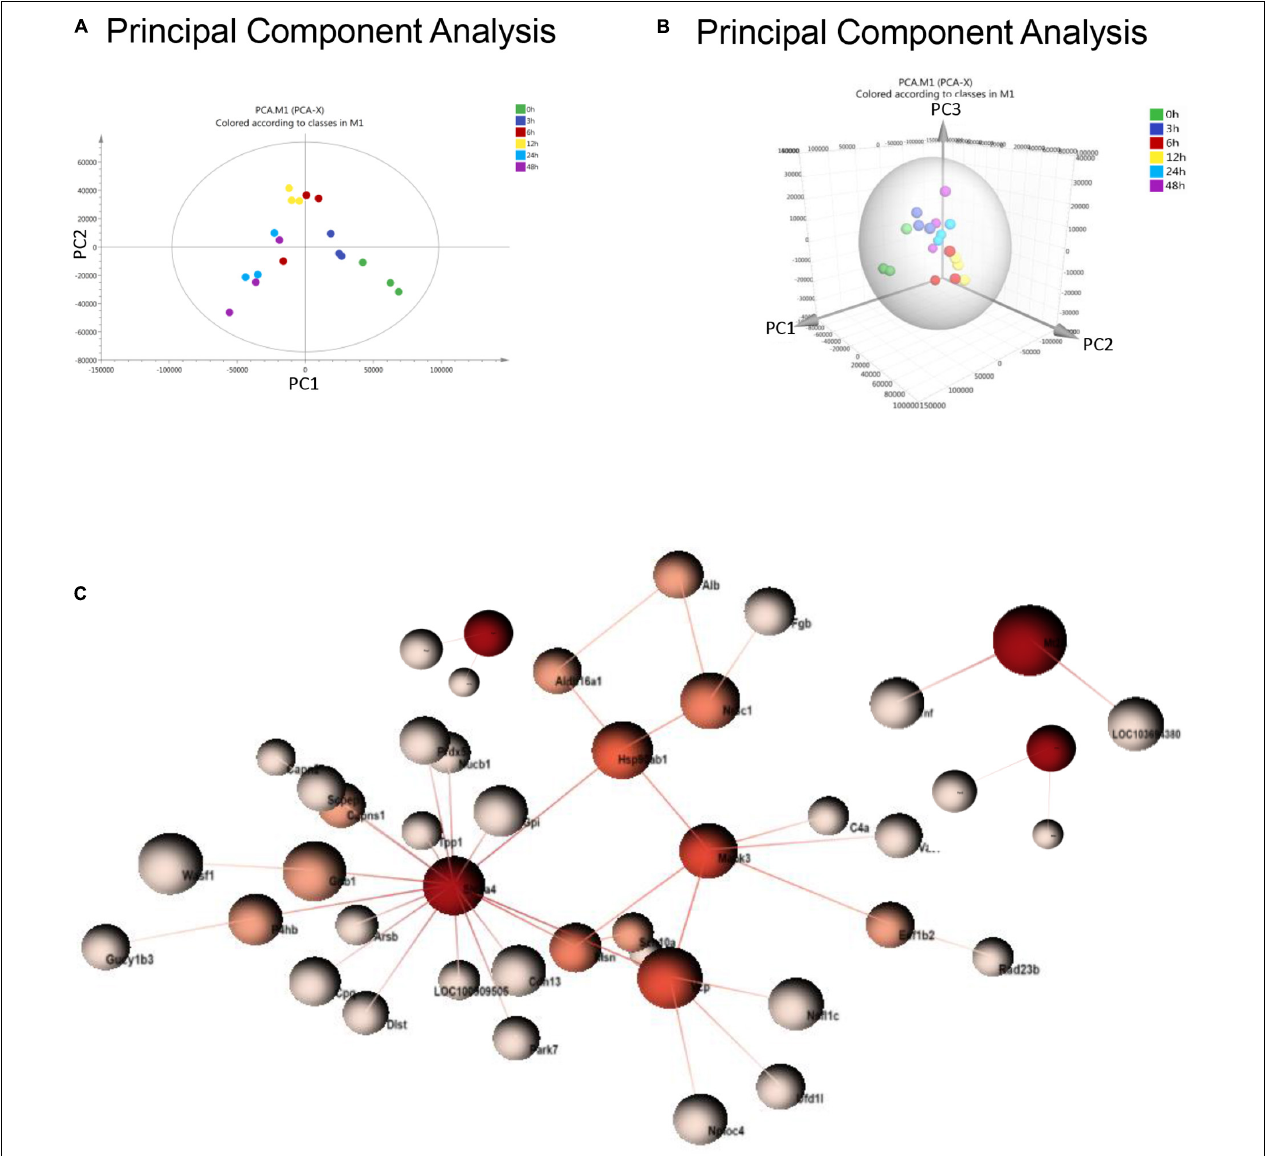
FIGURE 2 | PCA and PPI of urine proteomics. (A) PCA of urine proteomics. The PCA two-dimensional scatter plot represents the differential protein expression patterns of urine after sepsis. Axis: X = PC1: PCA Component 1 (48% variance); Y = PC2: PCA Component 2 (27.4% variance). (B) PCA were shown in the 3-dimensional figure. (C) PPI between differentially expressed proteins was analyzed by